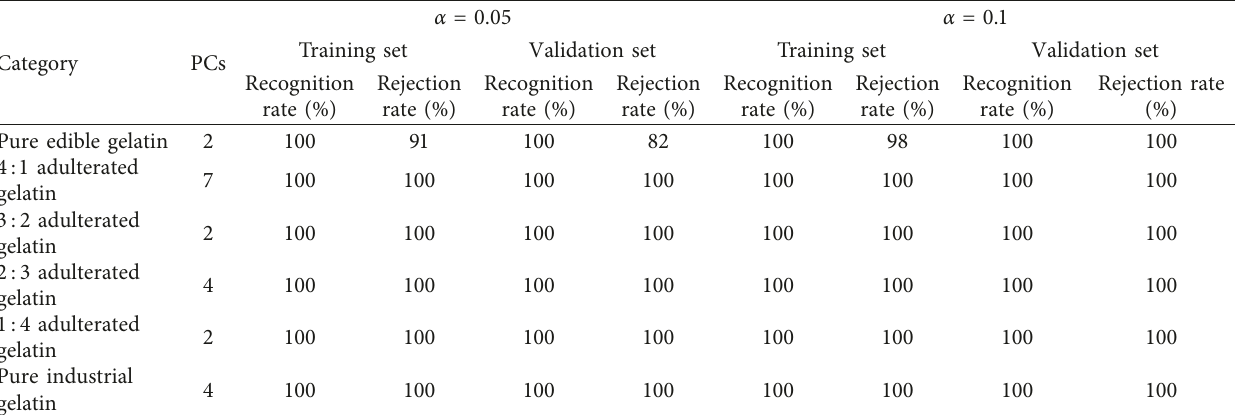
Table 3: Predicting results of SIMCA model in the training set and validation set when the significance level is 0.05 and 0.1, respectively. Category